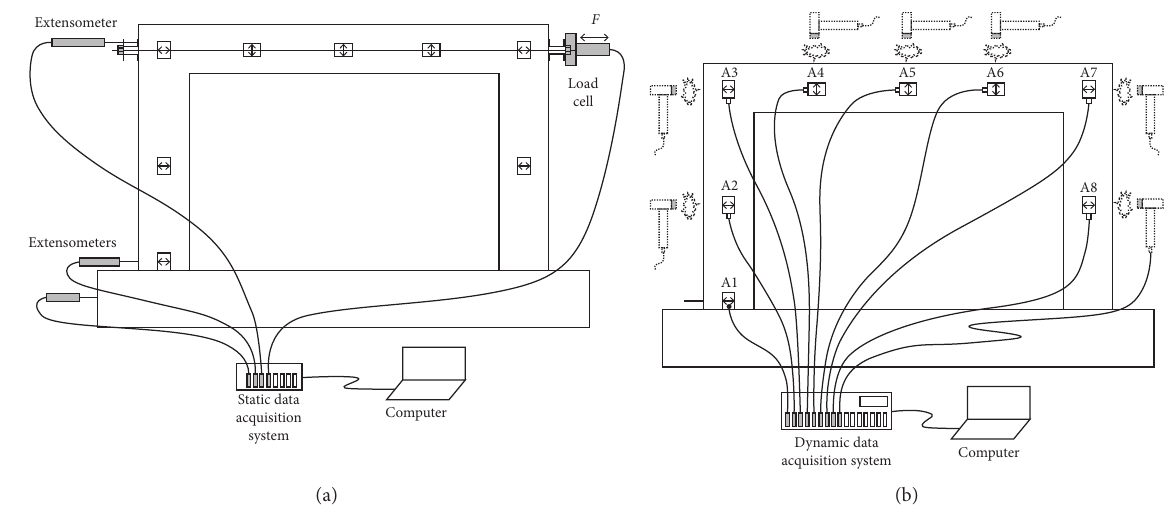
Figure 3: Schematic views of experimental setups for (a) lateral loading and (b) impact vibration